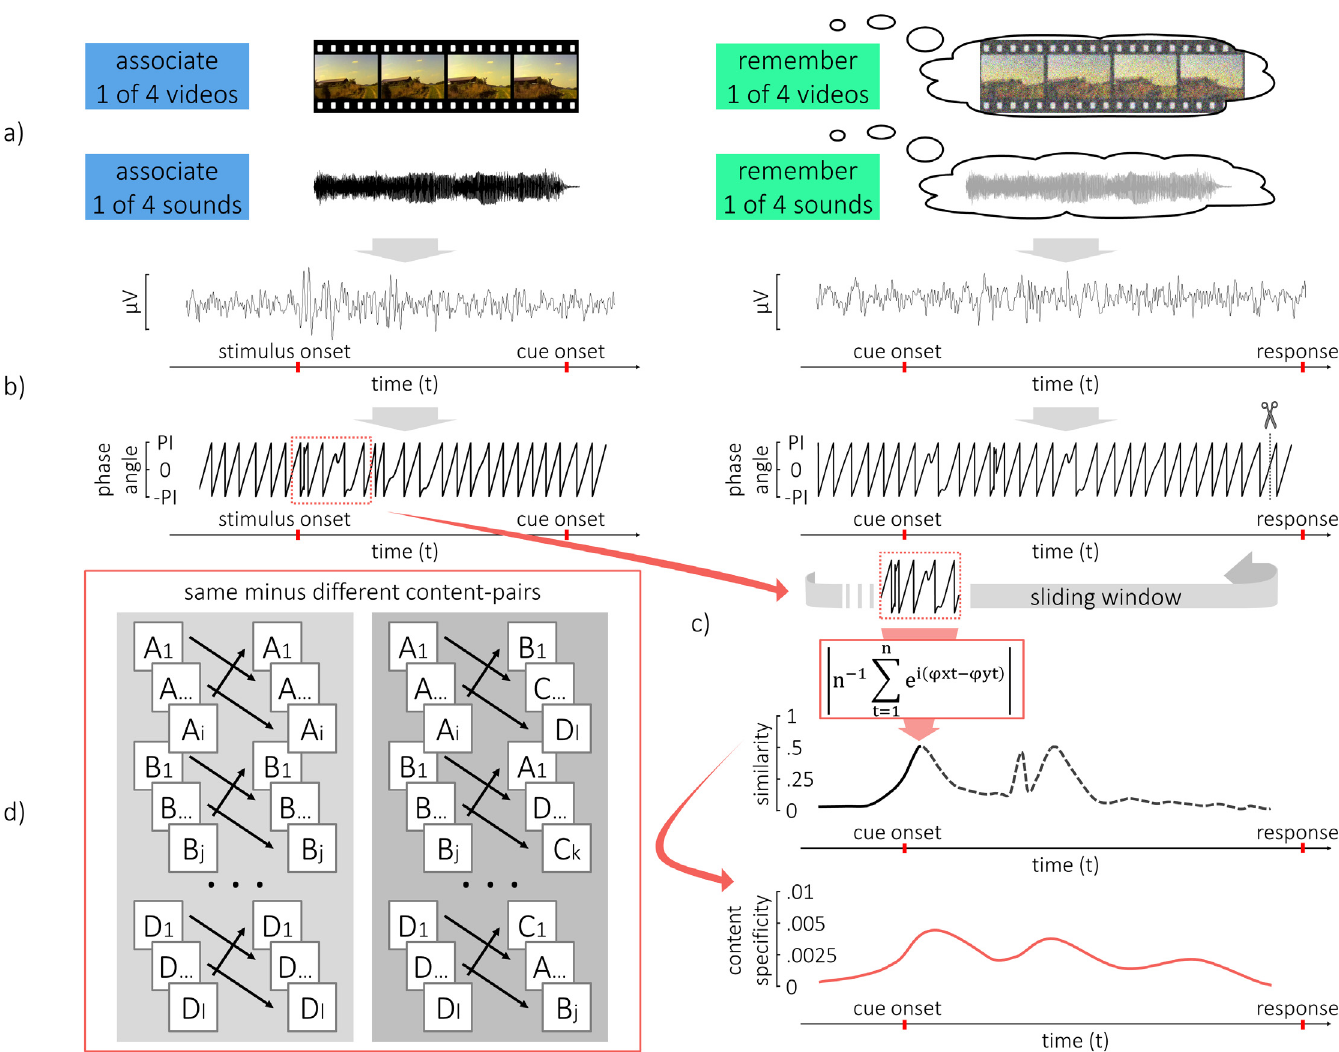
Fig 2. Detection of content-specific reinstatement of temporal patterns. (a) During encoding, subjects associated one of four videos with a different cue word in every trial in the visual condition, or they associated one of four sounds with different cue words in the auditory condition (a, left). During retrieval, subjects only saw the static word cue on the screen and were asked to recall the corresponding dynamic stimulus (a, right). (b) At every electrode, the oscillatory phase for a frequency of interest was extracted from the EEG activity. A time window from encoding was then selected and the time course of phase in this window was compared to retrieval. (c) A sliding window was used to assess the similarity, based on the constancy of phase angle differences over time (Single Trial Phase Locking Value [32,33]). This measure made it possible to assess similarity between single trials in which the strength of similarity ranged from 0 to 1, even though an oscillatory pattern was compared. Therefore similarity could be averaged across trials, time and participants. To avoid confounds from the response and the response scale, the data was cut at the end of the retrieval trial and the window was slid out, back into the pre-stimulus interval. This was done for trial-pairs of same content (e.g., learning A, remembering A) and for trial-pairs of different content (e.g., learning A, remembering D). (c,d) The difference in similarity between pairs of same and pairs of different content was interpreted as evidence for content specific reinstatement of temporal